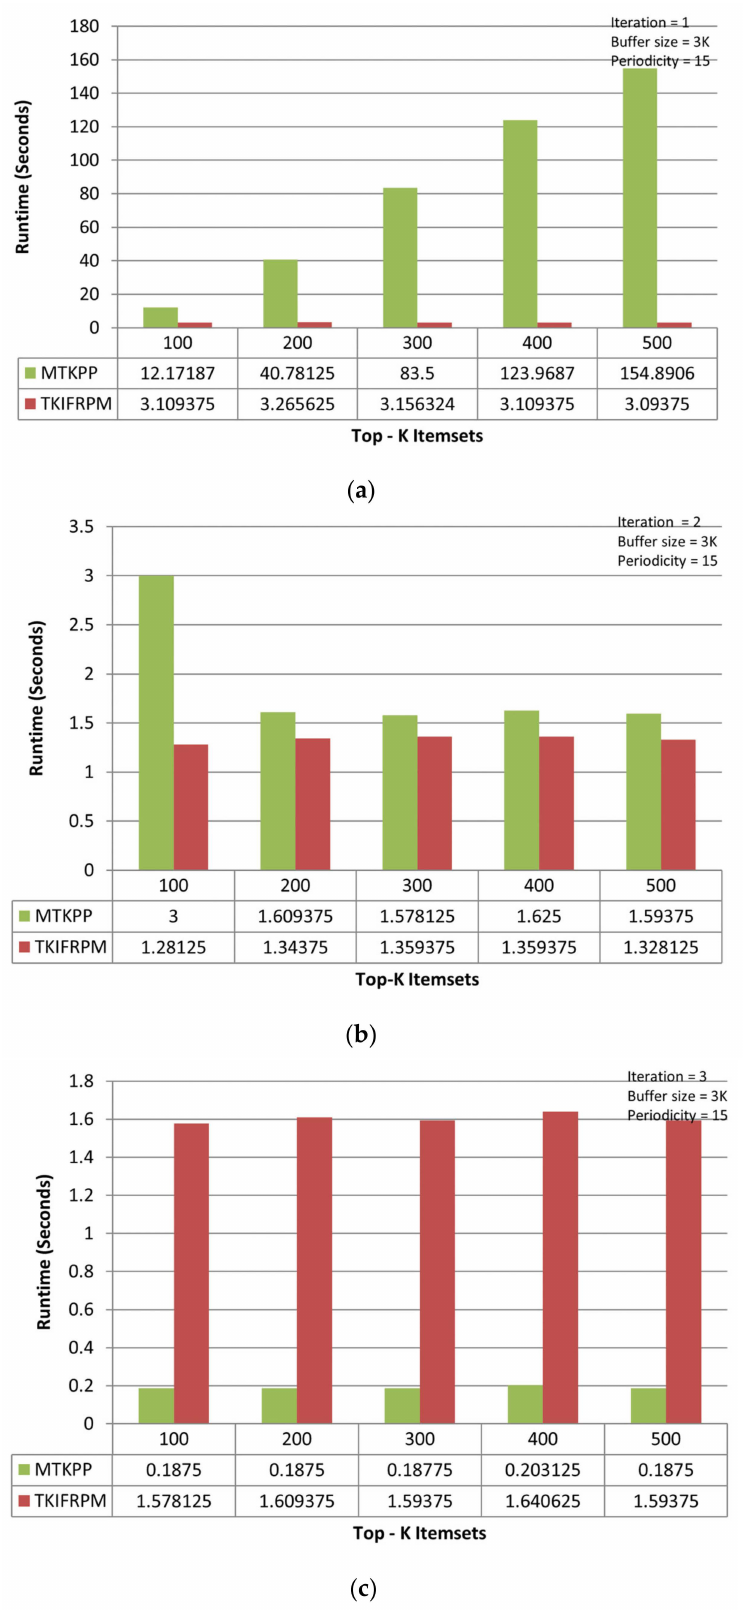
Figure 3. ( a ) Performance trends of the first iteration on the mushroom dataset. ( b ) Performance trends of the second iteration on the mushroom dataset. ( c ) Performance trends of the third iteration on the mushroom